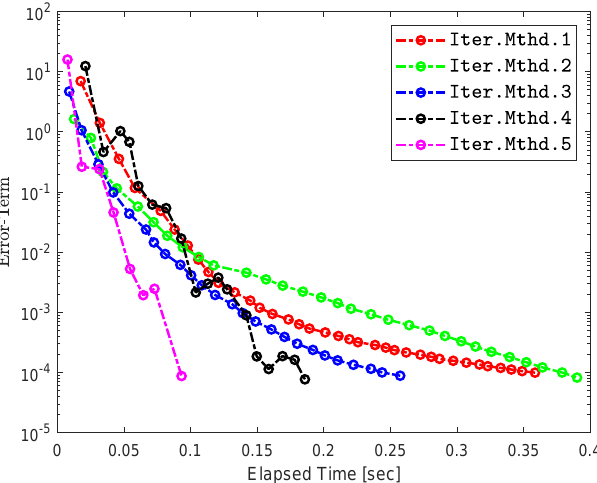
Figure 4. All techniques are computationally examined while s 0 = ( 1,2,1,2,3 ) T